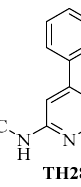
Figure 1. Chemical structure of TH287.